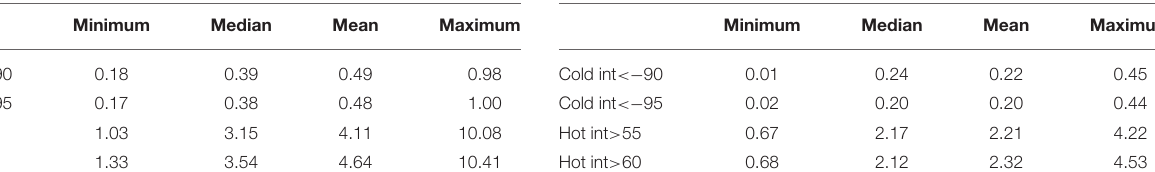
TABLE 6 | Distribution of the frequency changes for intense and very severe heat and cold waves between periods 1955–1986 and 1987–2017 obtained with the 23 climate model simulations, expressed as the ratio between frequencies in each period (frequency in 1987–2017/frequency in 1955–1986).